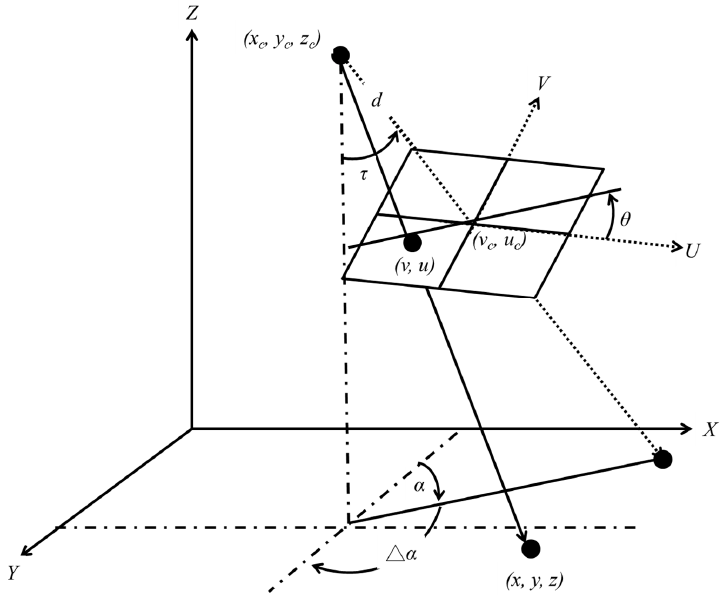
Figure 5. The collinearity relationship between the object ( x , y , z ), image point ( u , v ), and camera ( x c , y c , z c ). Note that ∆α is the change of angle from the initial azimuth α to the observation area. Table 1. Parameters used for right and left cameras and results of parameter sensitivity analysis. Rate of Change (RC) of Surface Velocity Using LSPIV (%) Parameter Right Camera Left Camera Parameter Used at Right and Parameter Used at Right and Left Cameras Increases 10% Left Cameras Decreases 10% u c